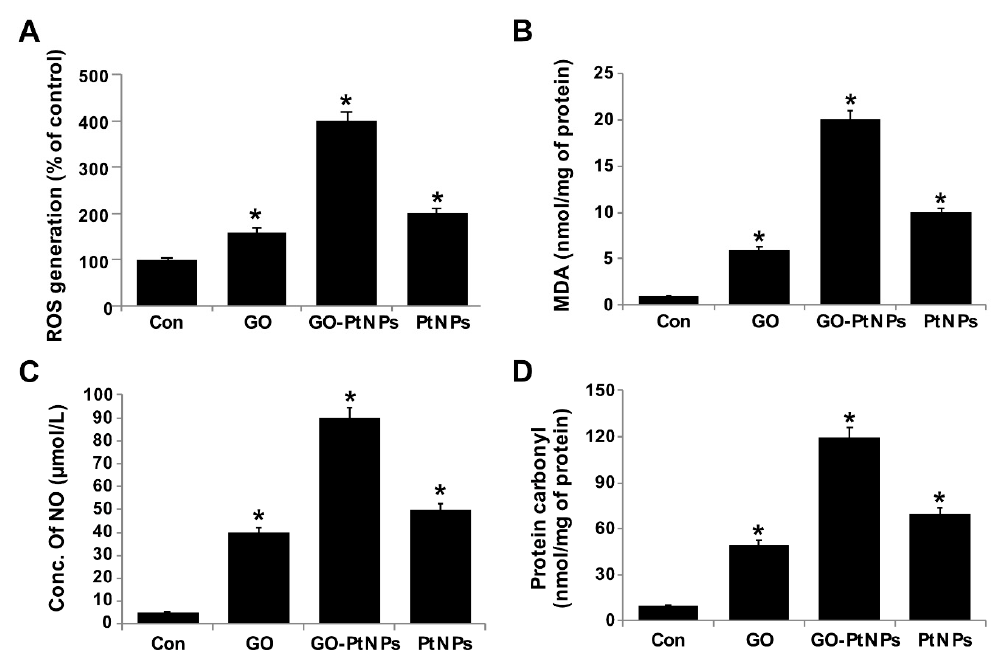
Figure 9. GO, GO-PtNPs, and PtNPs increase ROS generation ( A ), lipid peroxidation ( B ), and nitric oxide ( C ) and carbonylated protein content ( D ) in LNCaP cells. LNCaP cells was exposed to respective IC50 concentrations of GO, GO-PtNPs, and PtNPs for 24 h and then Spectrophotometric analysis of ROS was measured using DCFH-DA ( B ). The concentration of MDA was measured MDA using a thiobarbituric acid reactive substances assay and expressed as nanomoles per milliliter ( C ). NO production was quantified spectrophotometrically using the Griess reagent and expressed as micromoles per milliliter ( D ). Protein carbonyl content was measured and expressed relative to the total protein content. The treated groups showed statistically significant di ff erences from the control group by the Student’s t -test (* p <